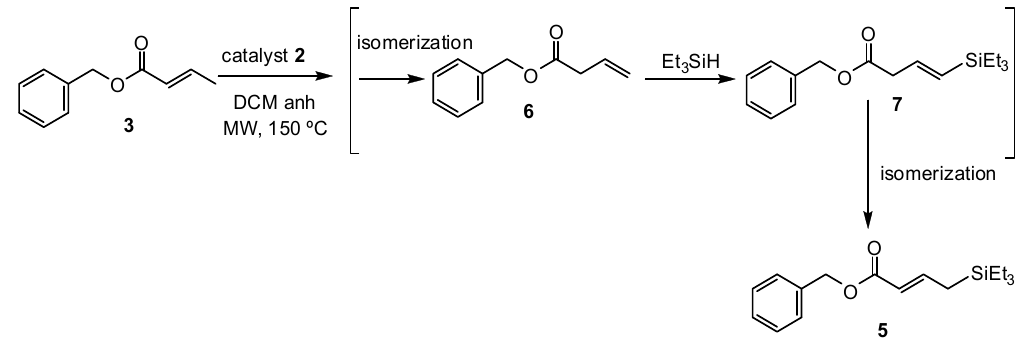
Scheme 1. Proposed mechanism for Et 3 SiH ‐ reduction of olefin 3 activated by catalysts 1 or 2 , according to Cossy et al. [9].